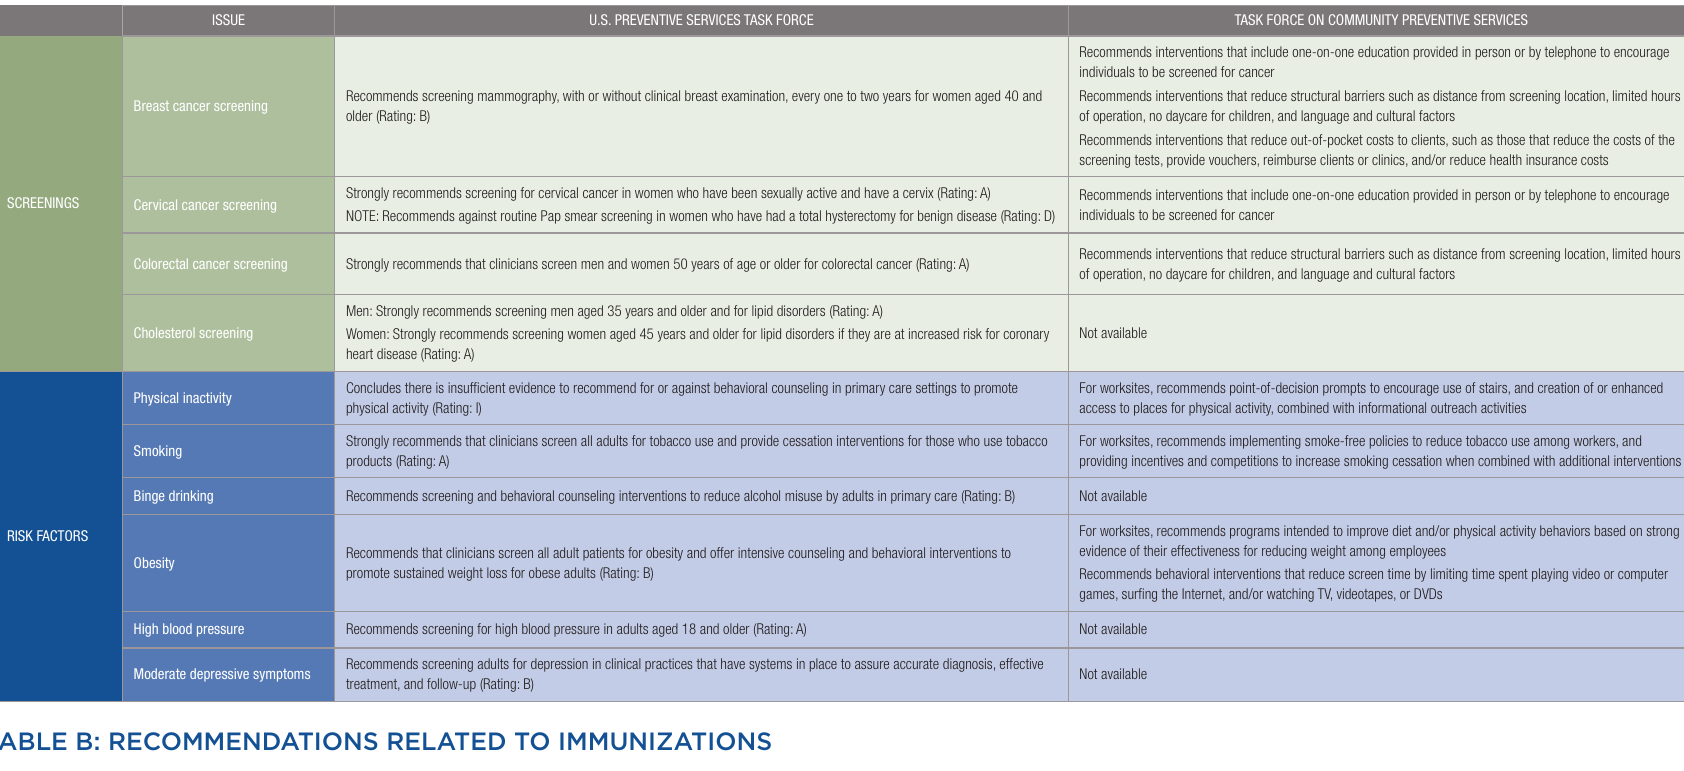
taBlE a: rECommEnDatIons rElatED to sCrEEnIngs anD rIsk FaCtors